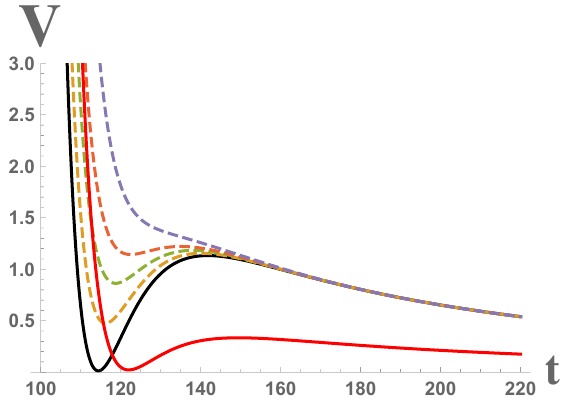
Figure 2 . The potential in the model (3.4) (multiplied by 10 15 ) for A = 1, a = 0 : 1, W 0 = (cid:0) 10 (cid:0) 4 . The black line shows the potential at c = 0 uplifted by increase of b to from 0 to b = 1 : 77 (cid:2) 10 (cid:0) 5 . The dotted lines show further uplift due to increase of c from 0 to c = 0 : 2 ; 0 : 4 ; 0 : 6, and 1. The last increase of c leads to destabilization of the dS minimum. The red line shows that if one takes c = 1 and decreases the value of b from b = 1 : 77 (cid:2) 10 (cid:0) 5 to b = 10 (cid:0) 5 , one (cid:12)nds a stable dS minimum, the same that is shown by the red line in (cid:12)gure 1, and in (cid:12)gure 2 in